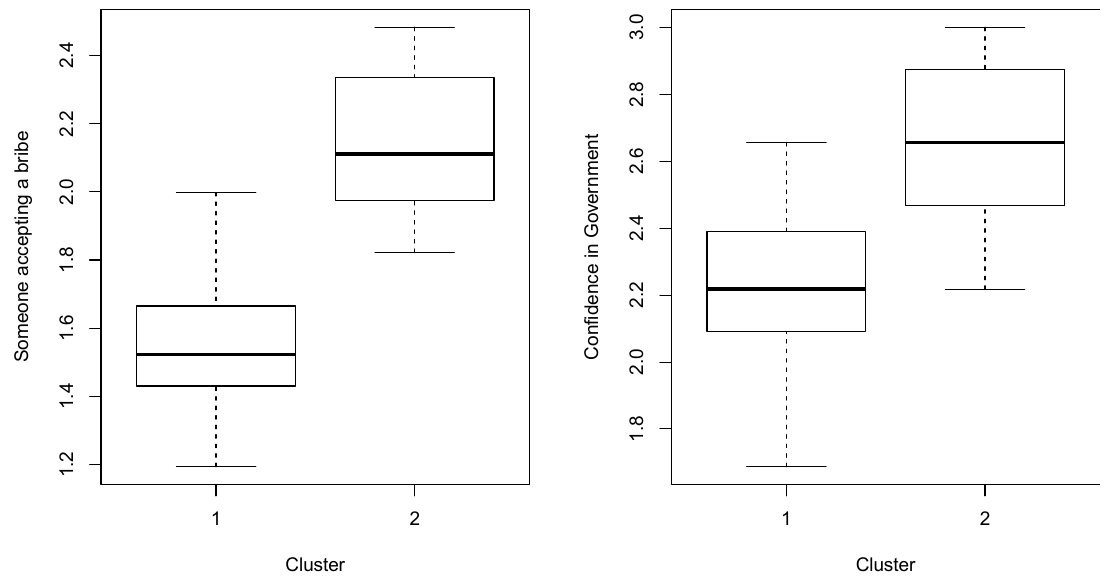
Figure 5. Box plot of Cluster Analysis.